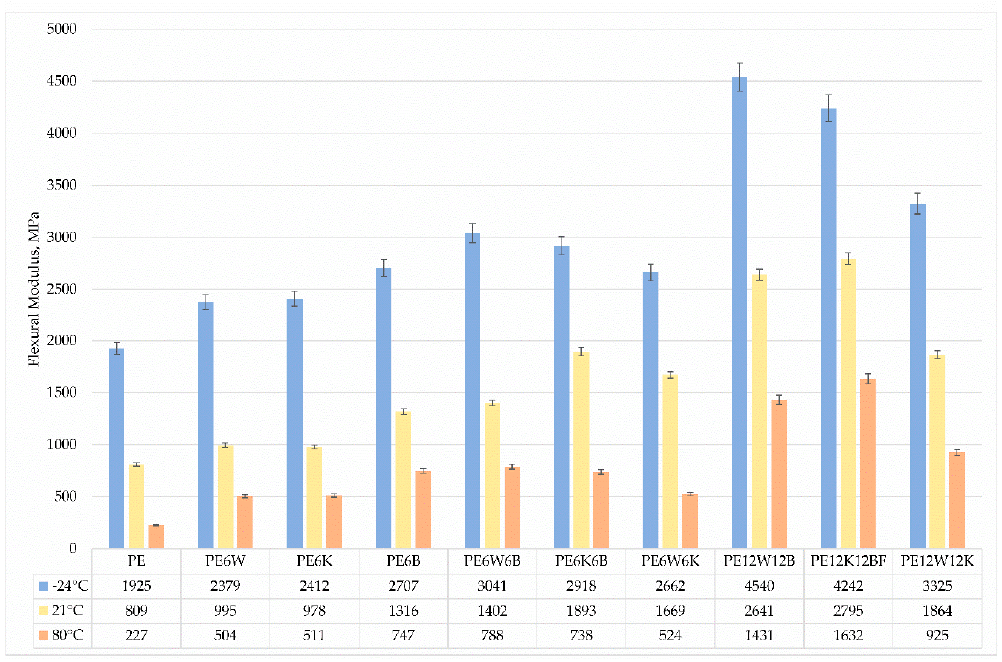
Figure 9. Comparison of flexural modulus at three different temperatures.